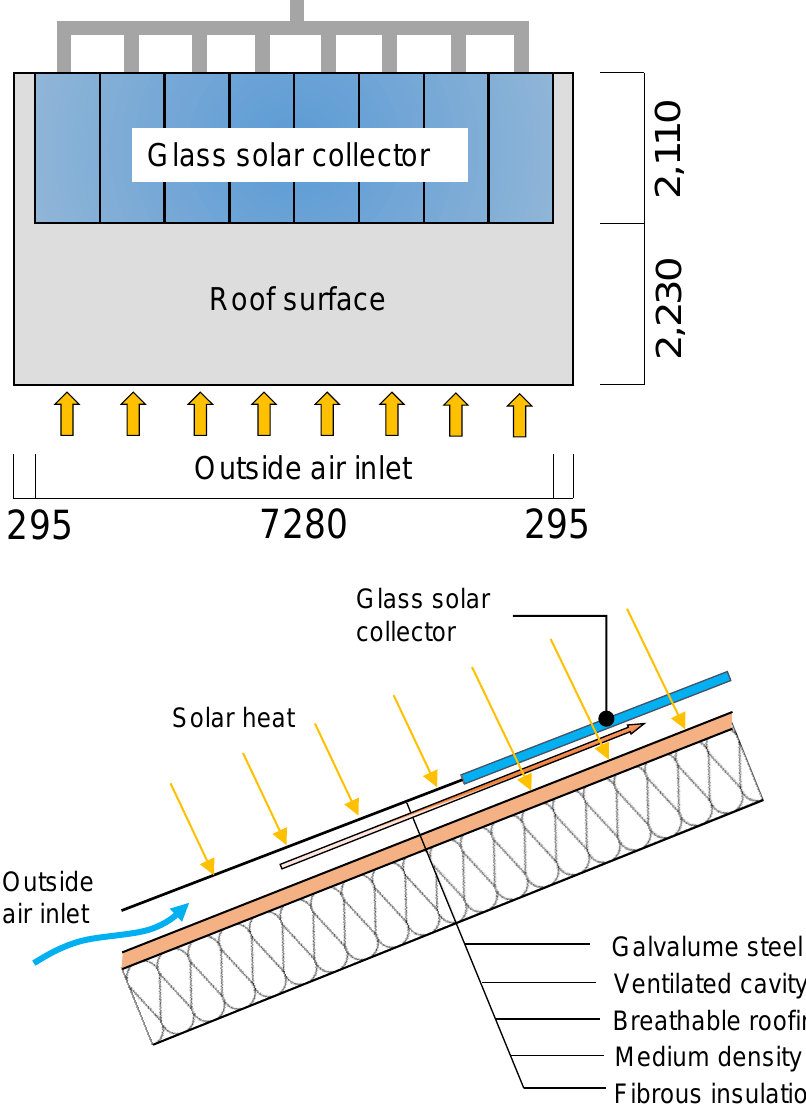
Figure 1. Roof composition with ventilated cavity and glass solar thermal collector (unit: mm). Figure 2a shows the system diagram of the conventional Type N system during the daytime when collecting heat. The solar heat is collected and distributed by the air flowing through areas (1)–(6) in order. (1) When the temperature on the ridge side of the ventilated roof cavity increases above 30 °C during winter, ~2.5 ACH outside air is introduced from the eaves to the ventilated roof cavity. (2) The outside air is warmed by the solar heat as it passes through the ventilated roof cavity and the glass solar thermal collector. (3) The collected outside air is blown under the floor through a duct. (4) The heat is stored in the foundation concrete and floor slab. (5) The air under the floor moves into the room